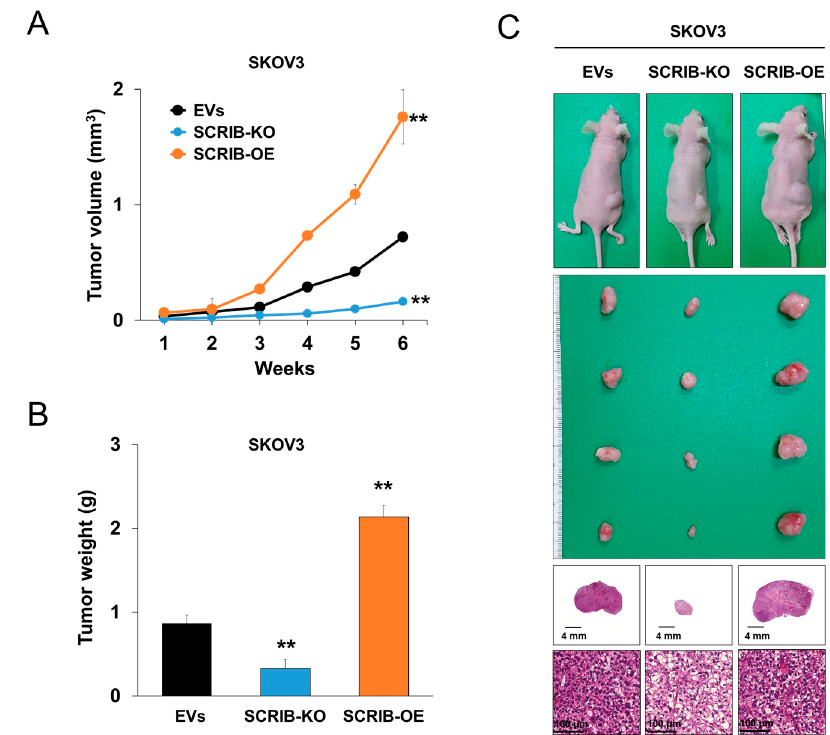
Figure 7. In vivo tumorigenic assay with knockout or overexpression of SCRIB in SKOV3 ovarian cancer cells. In vivo tumor growth was evaluated by subcutaneously implanting 2 × 10 6 SKOV3 cells transfected with empty vectors, vector for knockout of SCRIB , or a SCRIB overexpression vector. EVs; the cells transfected with both empty vector for knockout and empty vector for overexpression of SCRIB . ( A ) The tumor volume was measured every week after tumor implantation by the equation V = L × W × H × 0.52 mm 3 . ( B ) Six weeks after tumor inoculation, mice were euthanized, and tumor weight was measured. ( C ) Macroscopic and microscopic findings of xenografted tumors. ** p < 0.001.